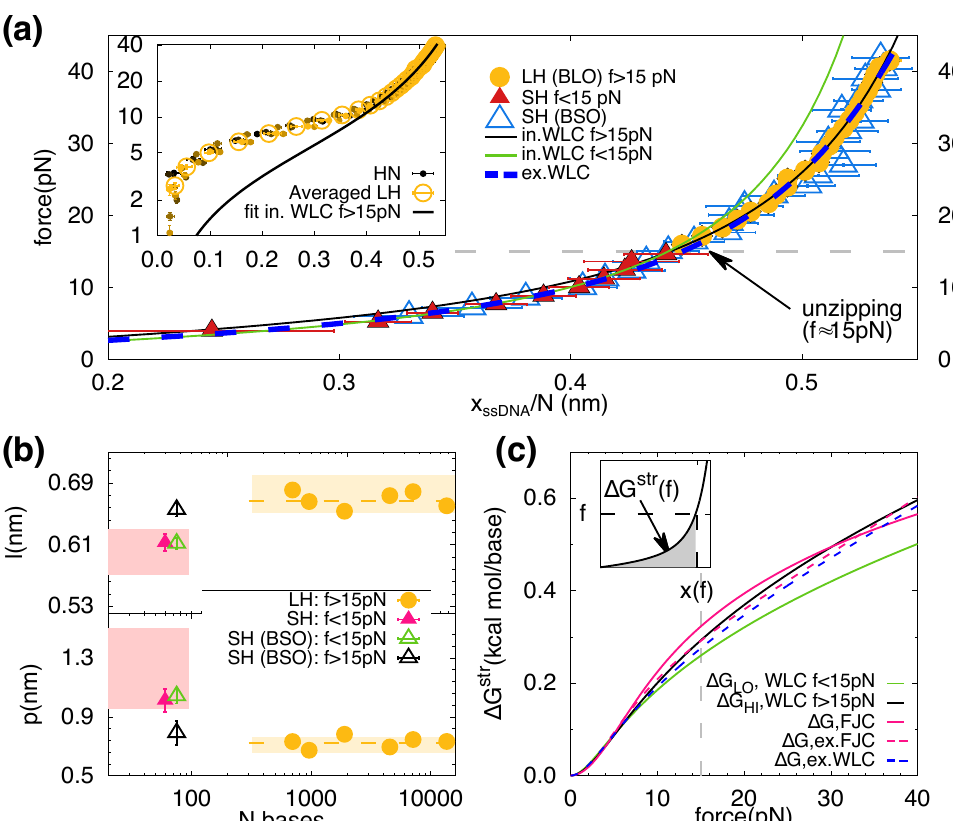
Figure 3. ssDNA elasticity ( a ) Averaged FECs over LHs data (yellow circles), SH (red triangles), SH using the BSO method (empty blue triangles). Extensions, x ssDNA , are re-scaled by the total number of nucleotides, N . Green and black curves are the fits of the FEC to Equation (7) below and above 15 pN, respectively. The horizontal dashed line represents the division between the two force regimes. The blue dashed line is a fit to the extensible WLC (Equation (8)) throughout the whole force range. (Inset) Filled circles represent the re-scaled FECs of all the long hairpins (HN, 348 ≤ N ≤ 6840, from darker to lighter color). The empty circles represent the averaged curve of all the studied lengths N > 348 bp. ( b ) Elastic parameters (contour length per base, l , and persistence length, p ) extracted from LHs (yellow circles) and SH (red triangles). The yellow horizontal dashed lines are the average values obtained for all LHs. The empty triangles are the fitting parameters extracted from the fits shown in panel ( a ): green for f < 15 pN, black for f > 15 pN. The magenta and yellow bands correspond to the range of elastic parameters reported in [39] for short (tens of bases) and long (thousands of bases) ssDNA. ( c ) Stretching energy per base as a function of the force, obtained from fitting the SH (BSO) data to different models. The magenta curves correspond to the values obtained from the FJC model (continuous line, c = 0.570 ( 4 ) nm, b = 1.36 ( 5 ) nm) and the extensible FJC (dashed line, c = 0.512 ( 10 ) nm, b = 1.75 ( 10 ) nm, S = 360 ( 70 ) pN). The dashed grey vertical line at 15 pN indicates the typical unzipping force. (Inset) Schematic depiction of the the free energy of stretching, shown as the grey area below the black curve describing the ssDNA